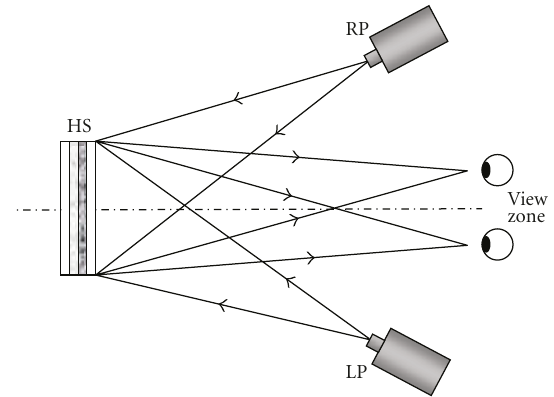
Figure 9: Optical arrangement for reconstruction of 3D images with one viewing zone from reflective holographic screen (HS) using left (LP) and right (RP)